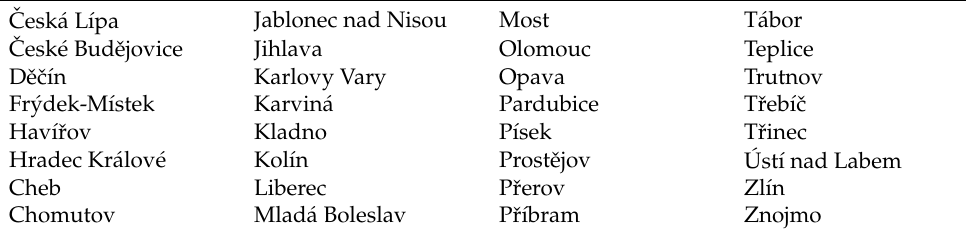
Table 2. List of names of municipalities included in the research sample.